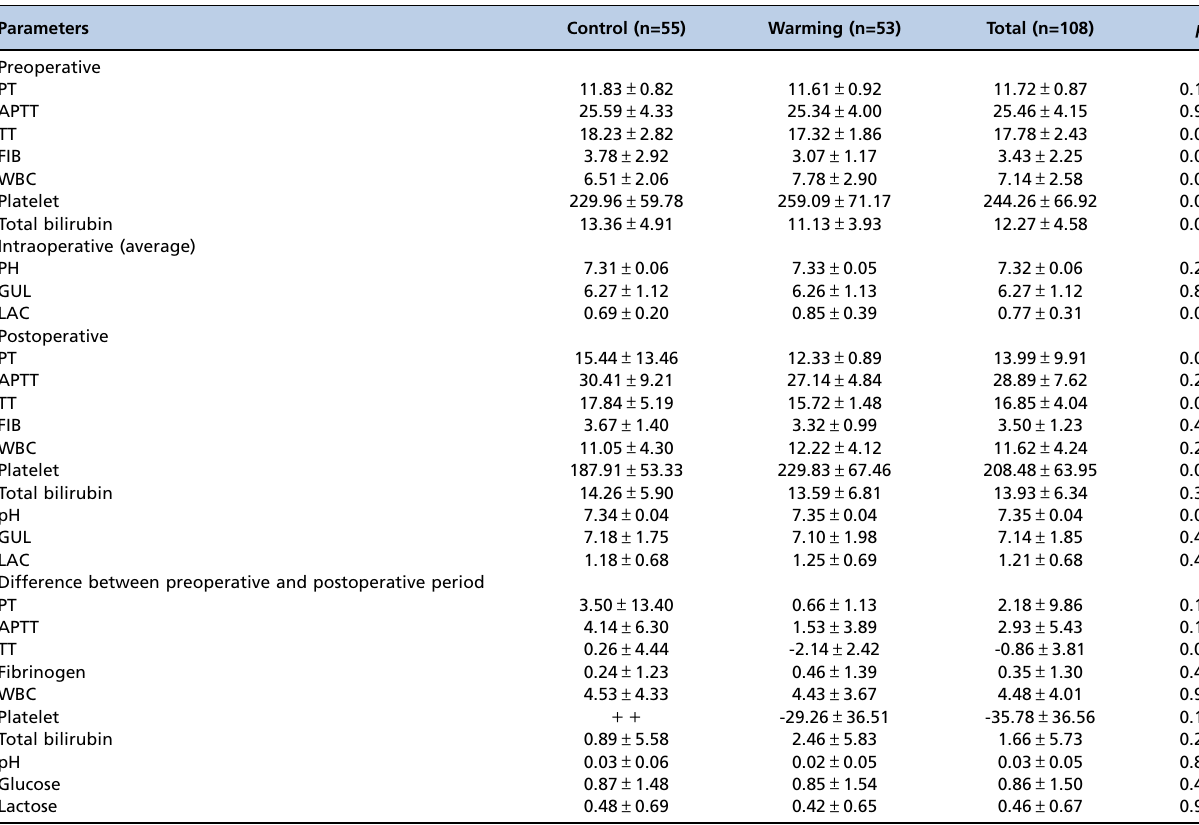
Table 4 - Laboratory results during perioperative period. Parameters